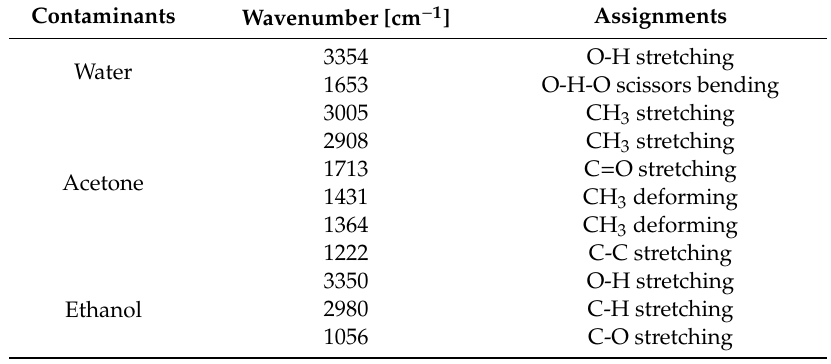
Table 2. FTIR band assignments of common biomass processing solvents on poplar